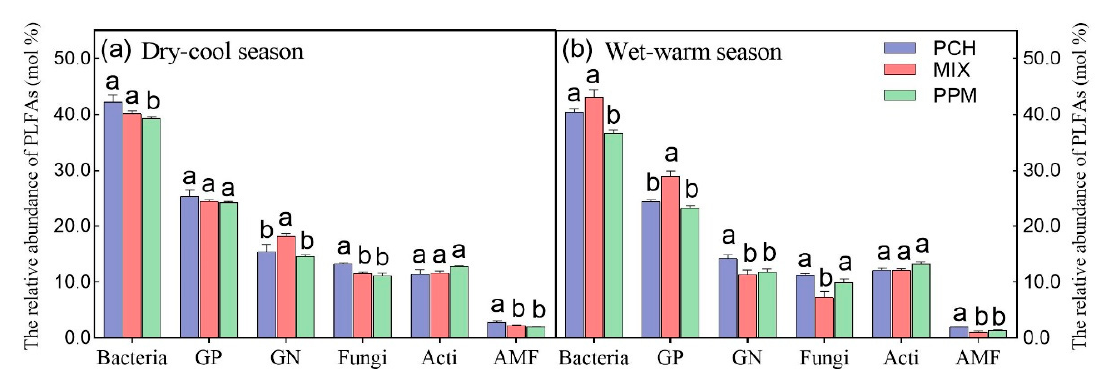
Figure 4. The relative abundance of PLFAs (mol %) in three plantations in the dry-cool season ( a ) and wet-warm season ( b ). Different letters above the bars denote significant differences at p < 0.05 level by LSD multiple comparisons among stand types ( n = 5).